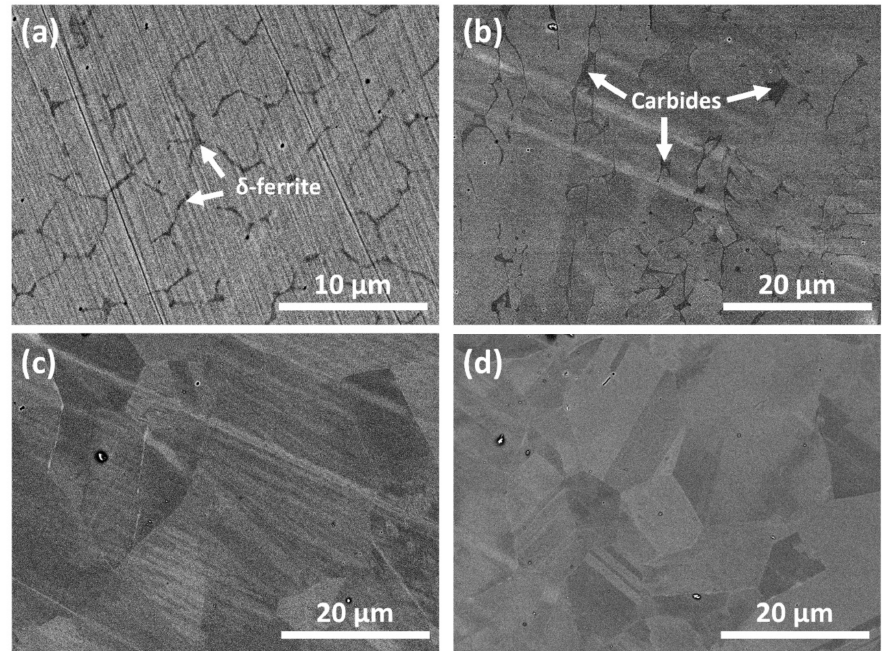
Figure 2. Metallurgical field emission scanning electron microscope (FESEM) images of stainless steel (SS) weld zone showing dendrite structure of δ -ferrite ( a ), chromium carbides ( b ), heat-affected zone ( c ), and base metal ( d